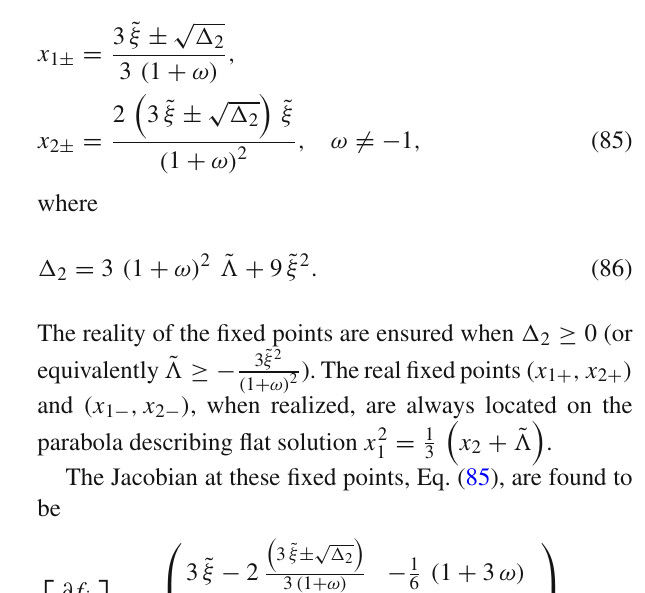
Fig. 10 The Hopf bifurcation diagram for all the four possible regions in the ( ˜ (cid:4), ˜ ξ) plane as divided by the solid curve, ˜ (cid:4) = − 9 ˜ ξ 2 and the ˜ ξ axis. 4 ( 1 + ω) The outward spiral indicates a repulsive center, the hollow circle indicates an unstable (source) fixed point, the circled D + denotes degenerate (non-hyperbolic) fixed point having one zero eigenvalue and one positive eigenvalue and half-filled circle represent a